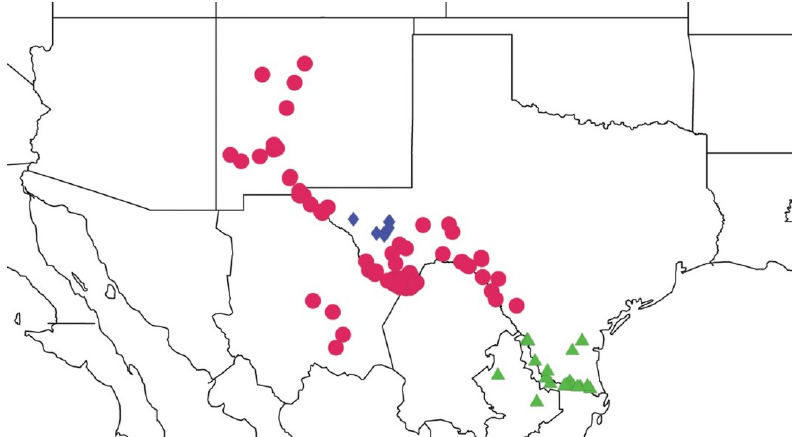
Figure 3. Distribution of Dicerprocta cinctifera cinctifera (red circles), D. cinctifera limpia (blue diamonds), and D. cinctifera viridicosta (green